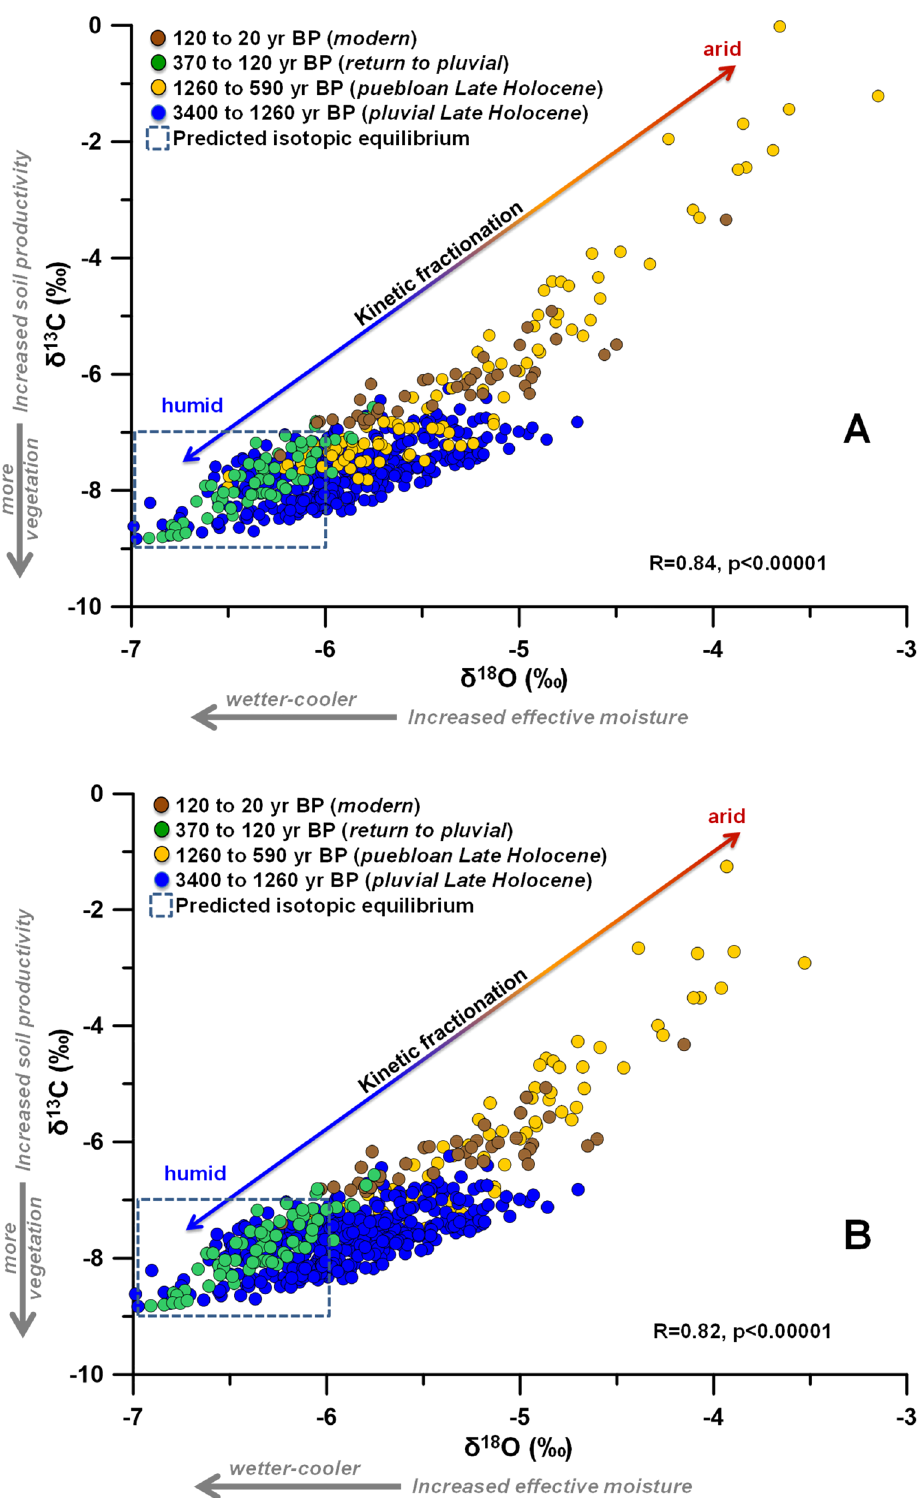
Figure 4. δ 18 O versus δ 13 C values illustrate an isotope fractionation trend due to evaporation and rapid CO 2 degassing. This trend is color-coded for each climatic sub-period and exhibits higher values along the trend that are coincident with the Pueblo period and with the last 150 years. Top and bottom graphs represent the same data uncorrected ( A ) and corrected ( B ) for percent of aragonite, respectively (Supplementary Information